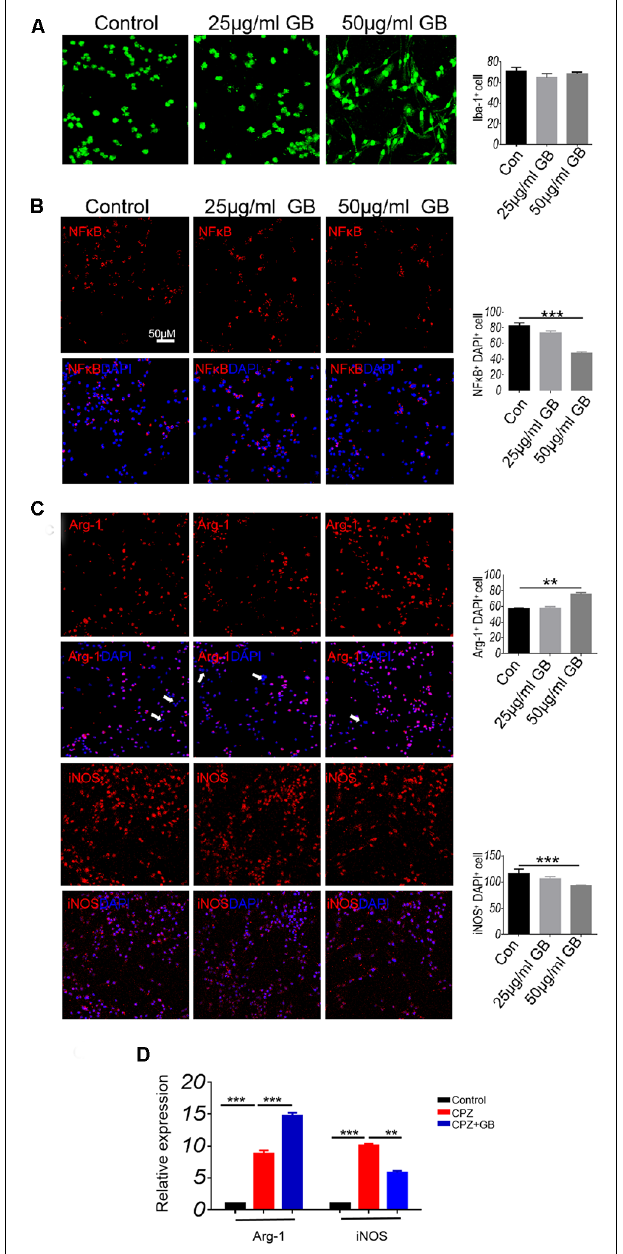
FIGURE 5 | GB influenced the phenotype of M1/M2 in BV2 cells. (A) Immunocytochemistry staining with anti-Iba-1 in BV2 microglia. (B) Double immunocytochemistry staining with anti-DAPI and anti-p-NF- κ B/p65 in the BV2 cells, (C) double immunocytochemistry staining with anti-DAPI and anti-Arg-1/anti-iNOS in the BV2 cells. (D) Relative expression of Arg-1 and iNOS mRNA in BV2 microglia by qPCR. Representative images are obtained from three replicate samples/each group, with similar results. The results represent the mean ± SEM. ∗∗ p < 0.01, ∗∗∗ p < 0.001.